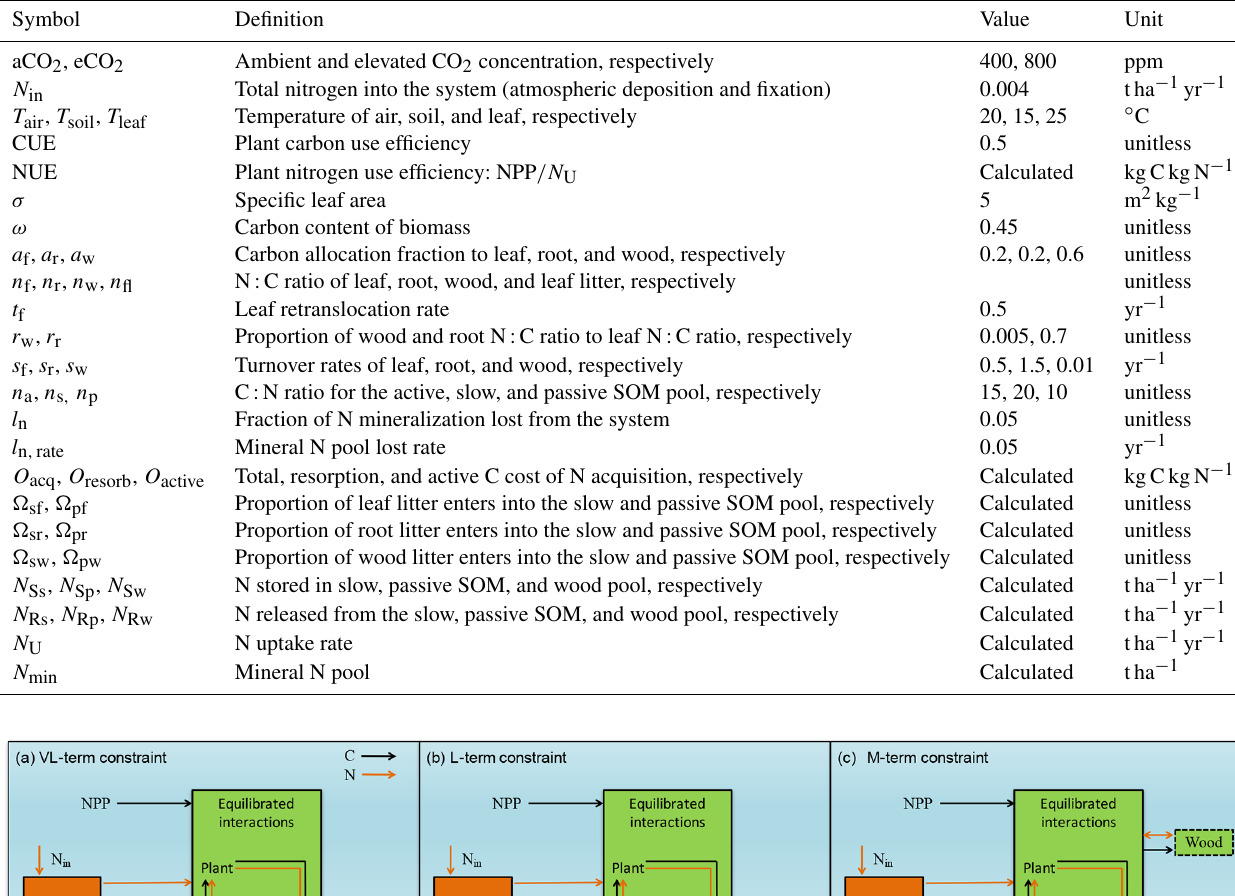
Table 2. Definitions of key variables for the baseline equations.